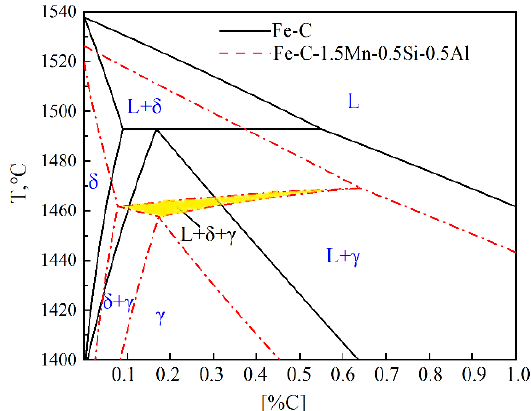
Figure 2. Pseudo-binary phase diagram of complex Fe-C alloy system.